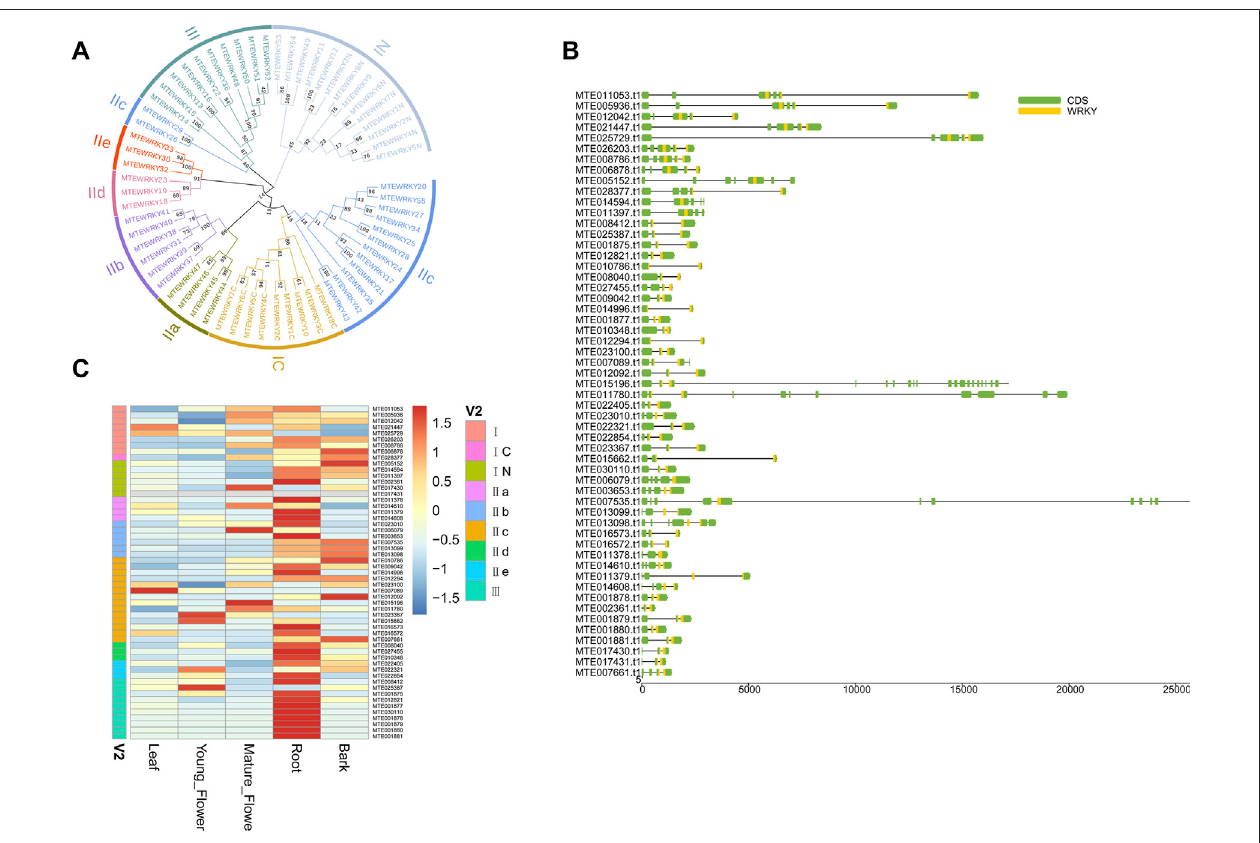
FIGURE 4 | Genome-wide investigation of WRKY gene family. (A) Unrooted phylogenetic tree among WRKY domains from macadimia genome. (B) Exon-intron structure of WRKY genes. (C) Expression pro fi les of the WRKY genes.